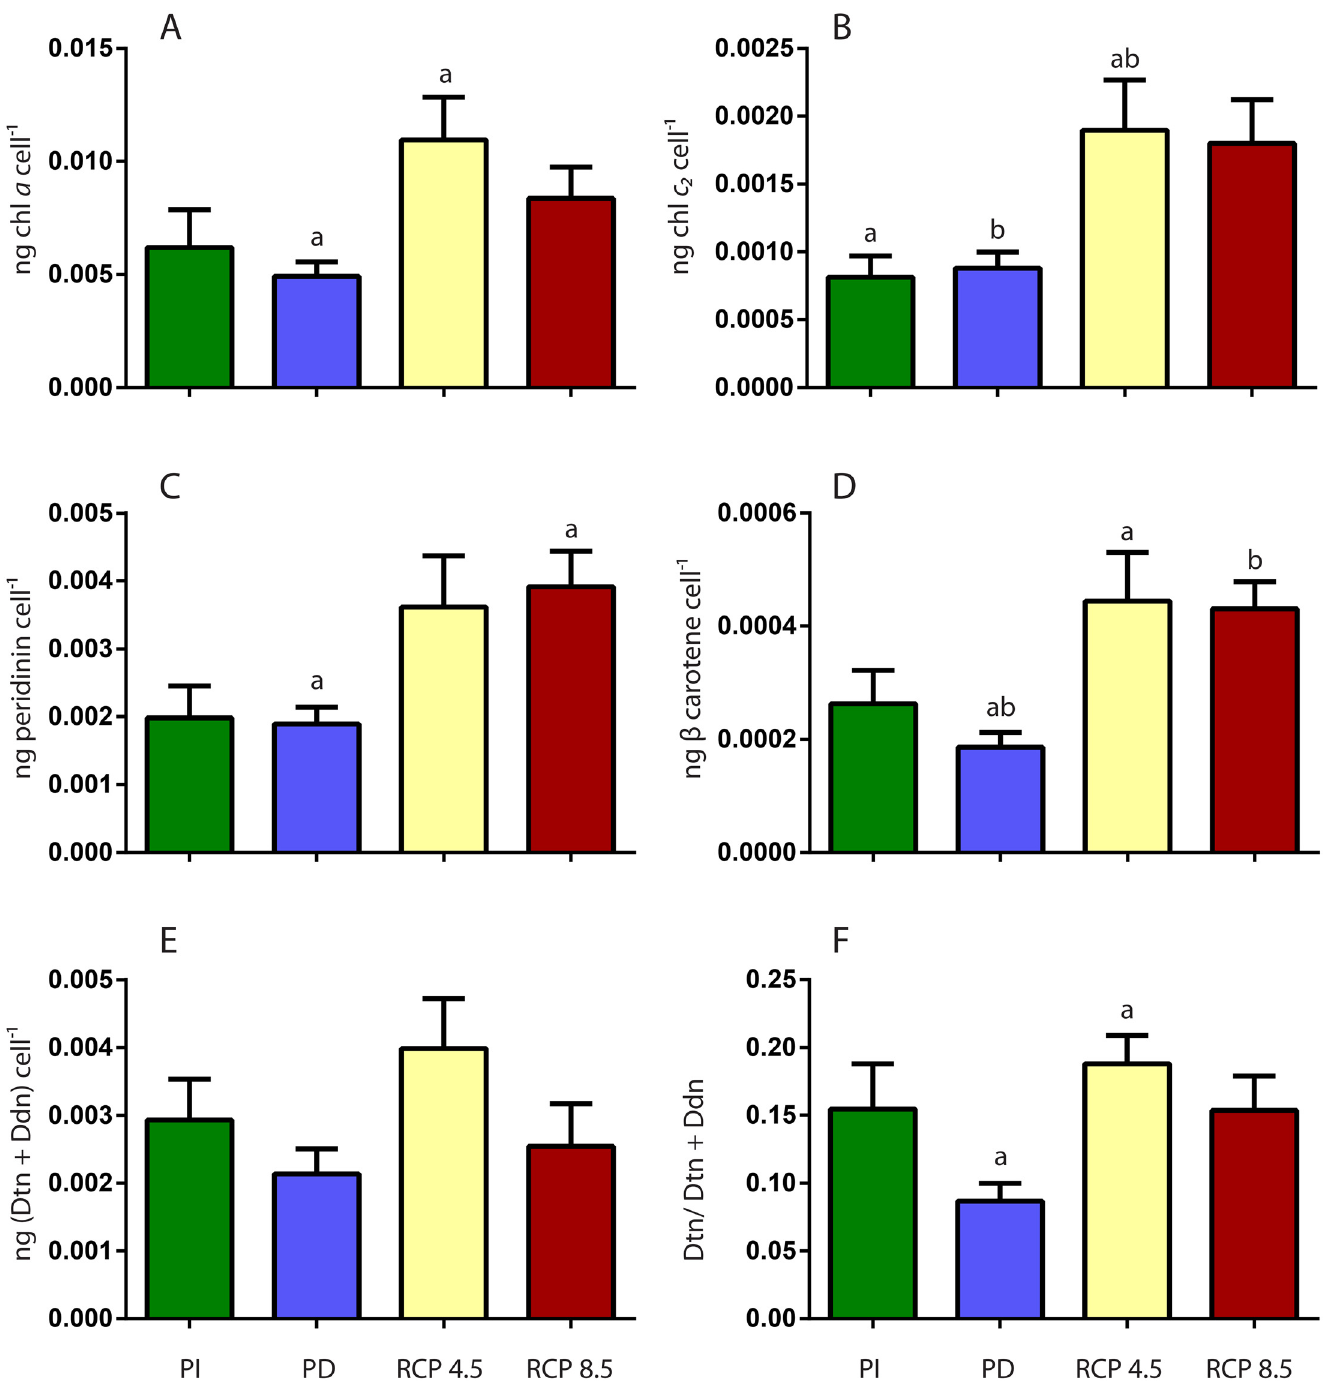
Fig 2. The effect of past and future changes in seawater temperature and pCO 2 (Pre Industrial, PI, Present Day, PD, Representative Concentration Pathway RCP4.5 and RCP8.5) conditions on Symbiodinium pigmentation. (A) Chlorophyll a content per cell (B) Chlorophyll c 2 content per cell(C) Peridinin content per cell (D) β carotene content per cell (E) Xanthophyll pool (diatoxanthin, Dtn and diadinoxanthin, Ddn) per cell and (F) Xanthophyll de- epoxydation. Error bars represent the standard error of the mean (n = 16). Post hoc differences are provided above the relevant data in letter symbols.